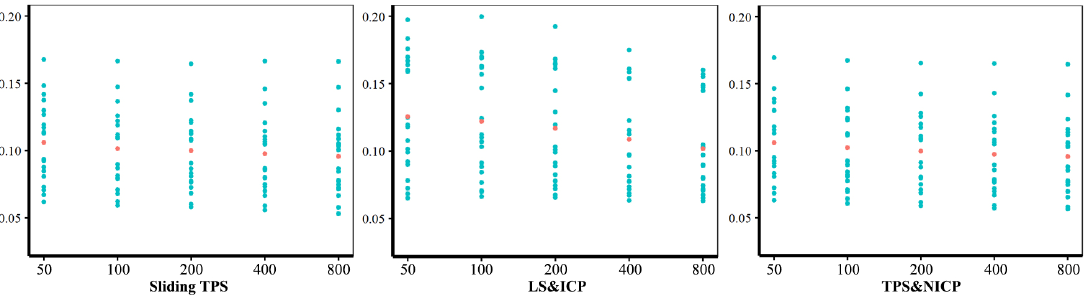
Figure 5. Comparison of the vector of Procrustes distances from the mean between semilandmarking approaches. ( a ) Sliding TPS vs. LS&ICP. ( b ) Sliding TPS vs. TPS&NICP.